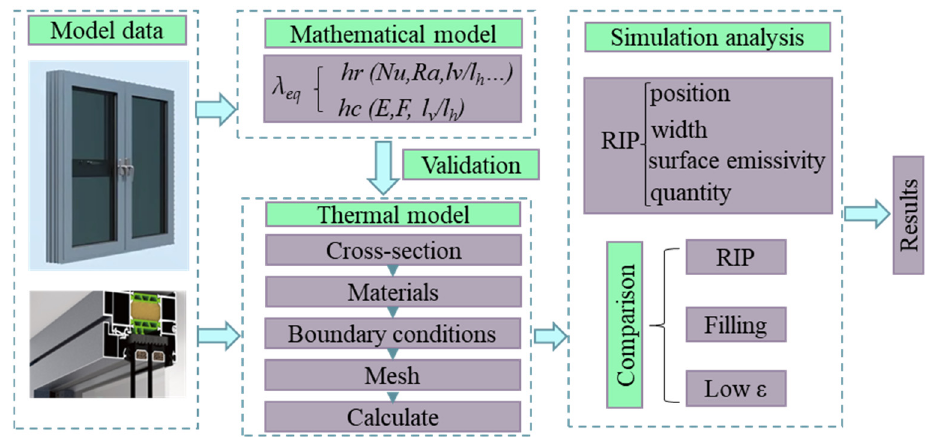
Figure 1. An outline of the research methodology.